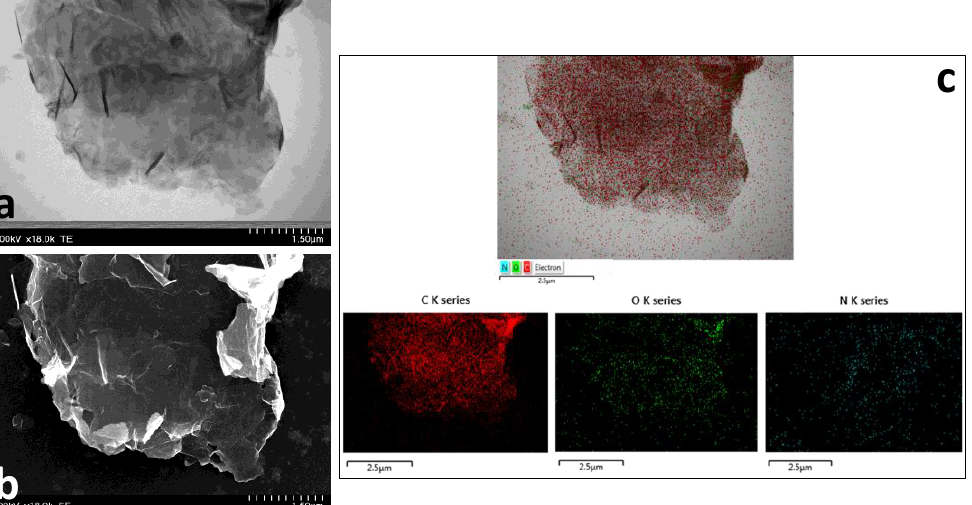
Figure 1. TEM/SEM micrographs corresponding to exf-NGr material ( a , b ); EDX mapping of C, O, and N atoms ( c ).